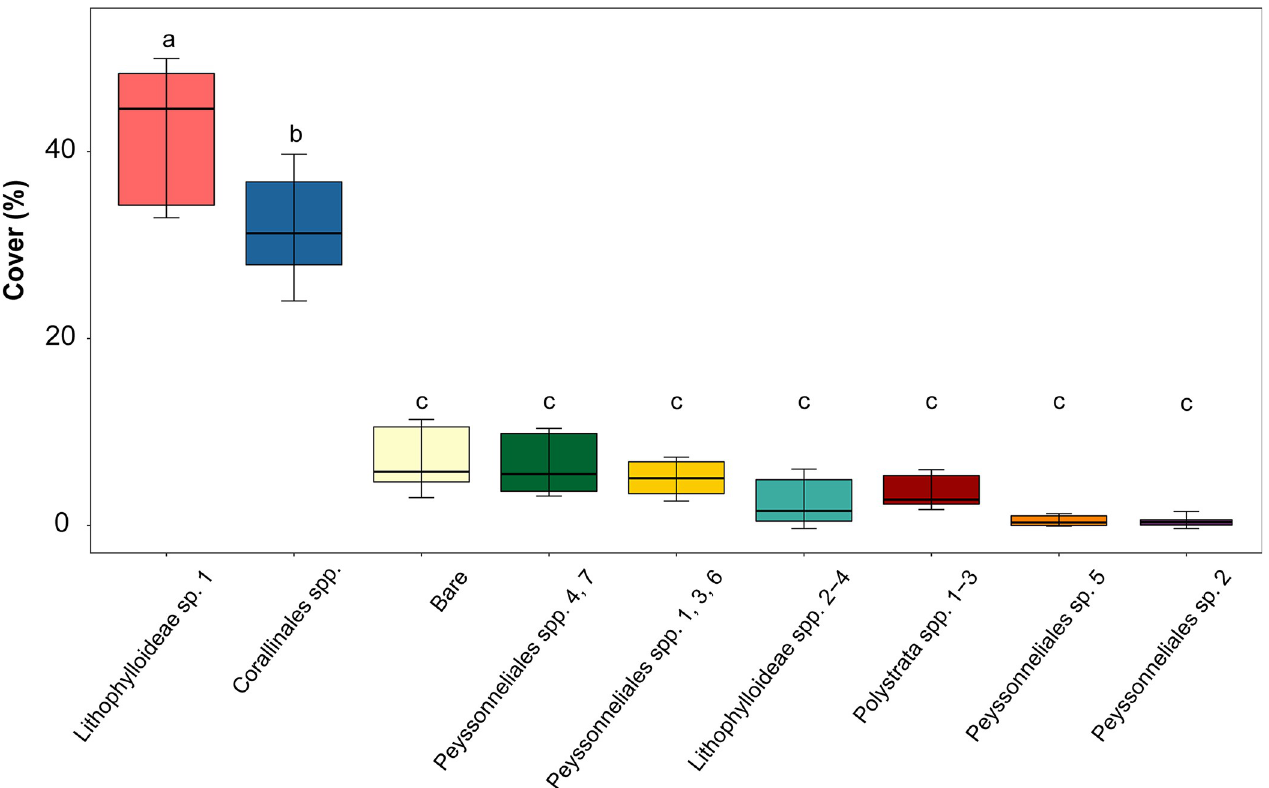
Fig 4. Box plot of the percent cover for each substrate category on the 12 coral recruitment tiles. The abscissa lists substrate categories, the ordinate shows percent cover. Median cover of a substrate category is indicated by a horizontal line in the interior of the box. The box represents the inter-quartile range (IQR) between the upper and lower quartiles. Whiskers indicate the minimum and maximum values beyond the IQR. Letters indicate significant differences between island groups ( P > 0.05). Box colors match substrate category colors in Figs 1 and 5.